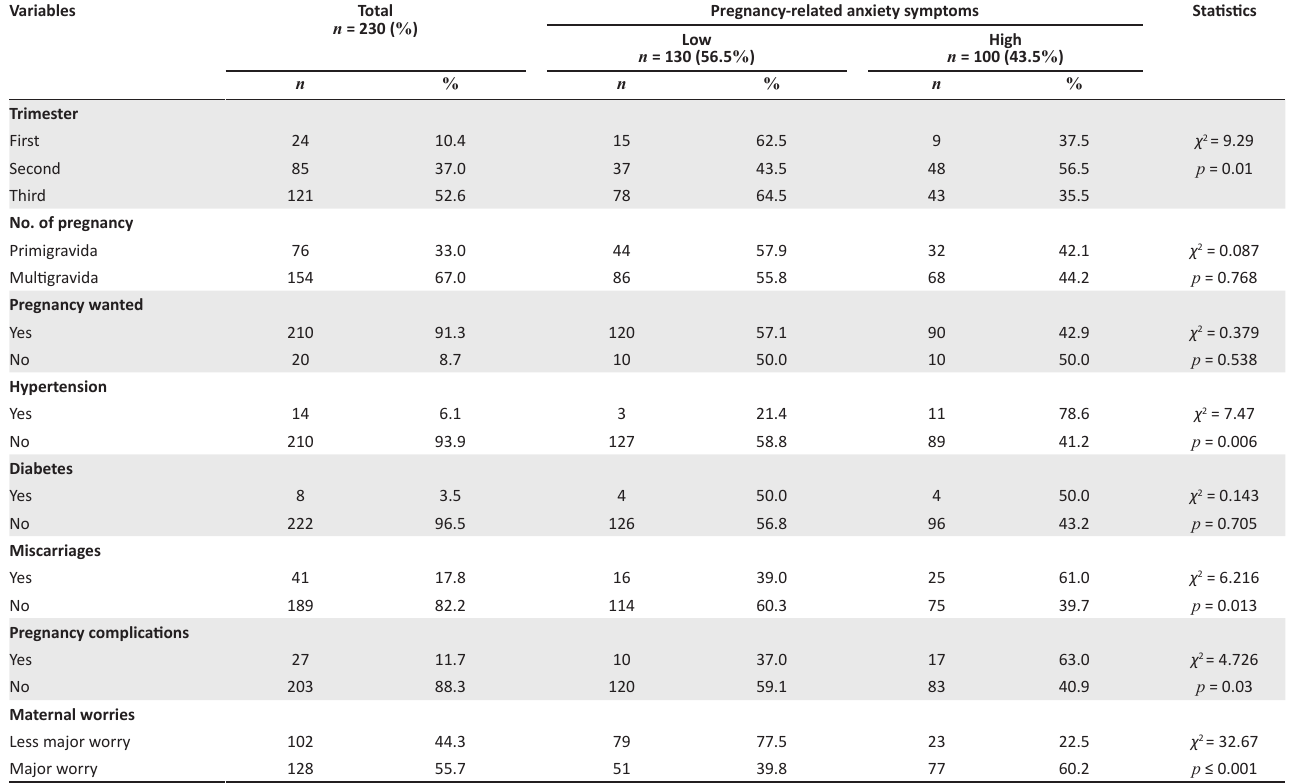
TABLE 3: Pregnancy-related factors in association with pregnancy-related anxiety symptoms amongst respondents. Variables